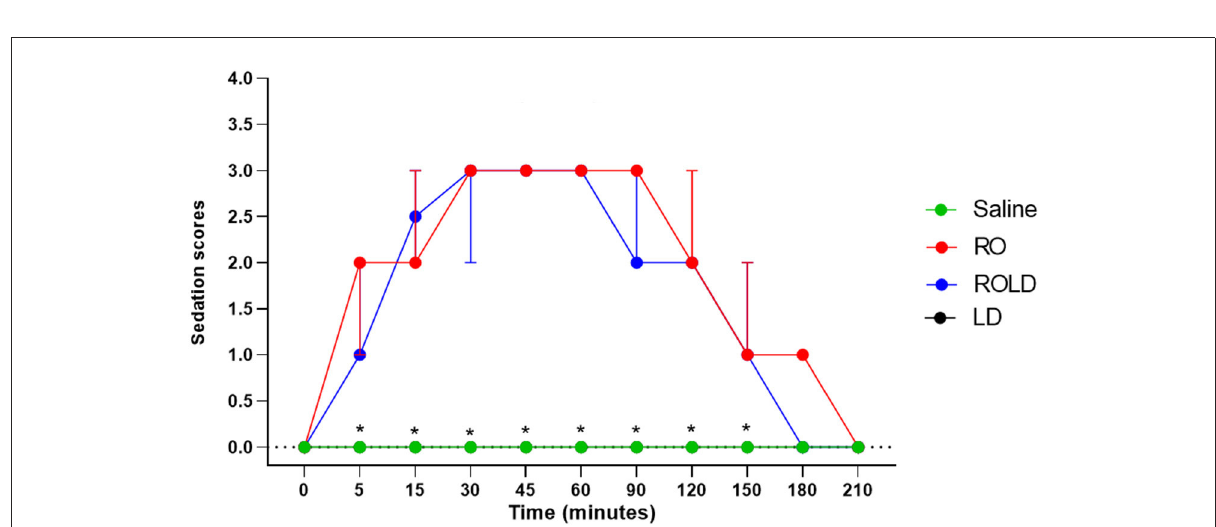
FIGURE5 Sedation scores (median and range) pre- epidural and post- epidural injection of saline ( n = 6), romifidine (RO) (50 µ g kg − 1) ( n = 6), romifidine-lidocaine (ROLD) (50 µ g and 0.30mg kg − 1) ( n = 6) and lidocaine (LD) (0.3 0mg kg − 1) ( n = 6) in donkeys. *: Saline and LD differ significantly from RO and ROLD